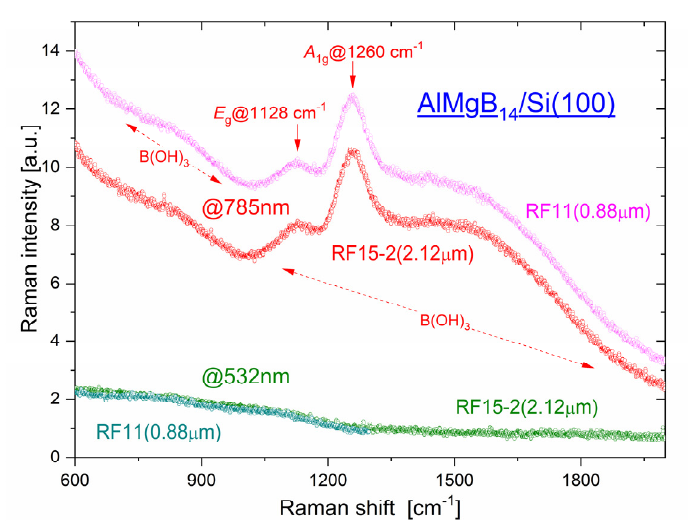
Figure 3. Unpolarized backscattered Raman spectra of two RF15-2(2.12 μ m) and RF11(0.88 μ m) AlMgB 14 films grown onto Si(100) wafers, respectively, at 250 °C and 300 °C. Excitations at 785 nm (1.58 eV) and 532 nm (2.33 eV) laser light pumping are shown with red/magenta and green/cyan colors, correspondingly. Two vertical arrows mark Raman intra-icosahedral B-B vibration E g band at 1128 cm − 1 and inter-icosahedral B-B vibration A 1g modes at 1260 cm − 1 . Raman and IR active vibrations in the molecule of orthorhombic boric acid B(OH) 3 build the shoulder around 840 cm − 1 and a broad 1030–2000 cm − 1 band.